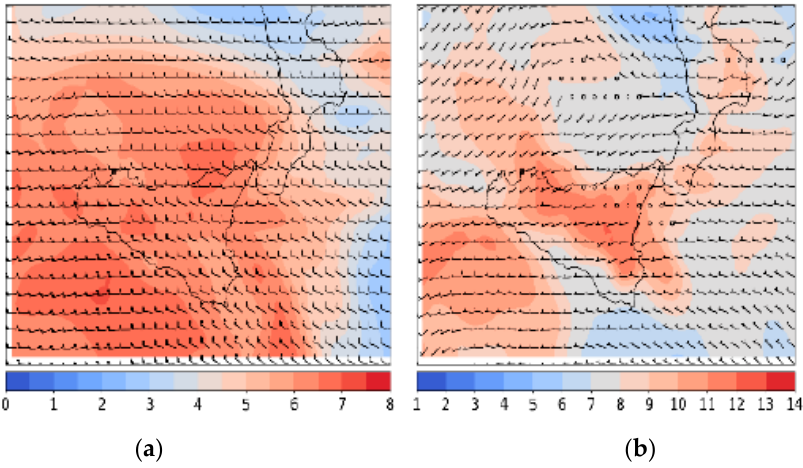
Figure 3. Specific humidity (g/kg) and wind (barbs) at 700 ( a ) and 850 ( b ) hPa at 15:00 UTC. ECMWF- HRES forecast (+3 h) starting on 15 July 12 UTC.